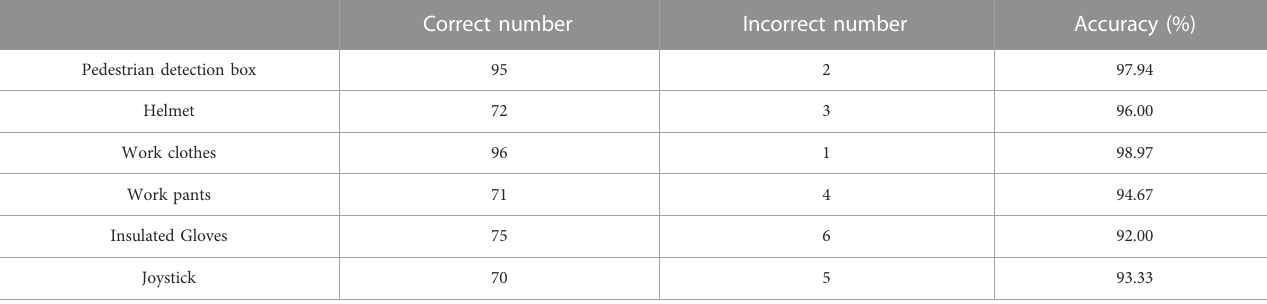
TABLE 6 Safety wears identi fi cation results.